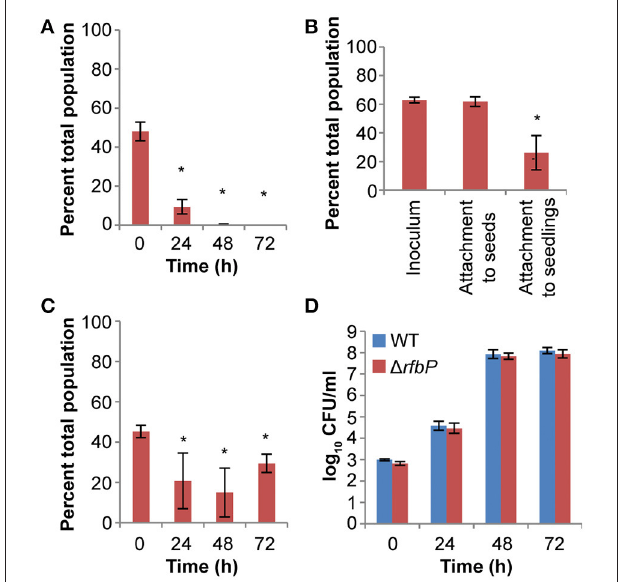
FIGURE 5 | O-antigen contributes to S. enterica plant colonization. (A) 14028S 1 rfbP , an O-antigen mutant, was less competitive than the isogenic WT in alfalfa seedling colonization. *, statistically different from 50% (Student’s t -test, n = 3, p < 0.05). (B) O-antigen contributed to attachment to 3 d-old seedlings but not seeds. *, statistically different from inoculum (Paired t -test, n = 6, p < 0.05). (C,D) 1 rfbP had a subtle growth defect in alfalfa seedling exudates that is revealed only in competition with the isogenic WT. (C) *, statistically different from 50% (Student’s t -test, n = 3, p < 0.05). (D) *, statistically different from WT (Paired t -test, n = 6, p < 0.05). WT and mutant were inoculated at a 1:1 ratio for all competition experiments (A,B,C) . All data shown represent the means of 3 independent experiments with 3 replicates each. Error bars indicate the standard